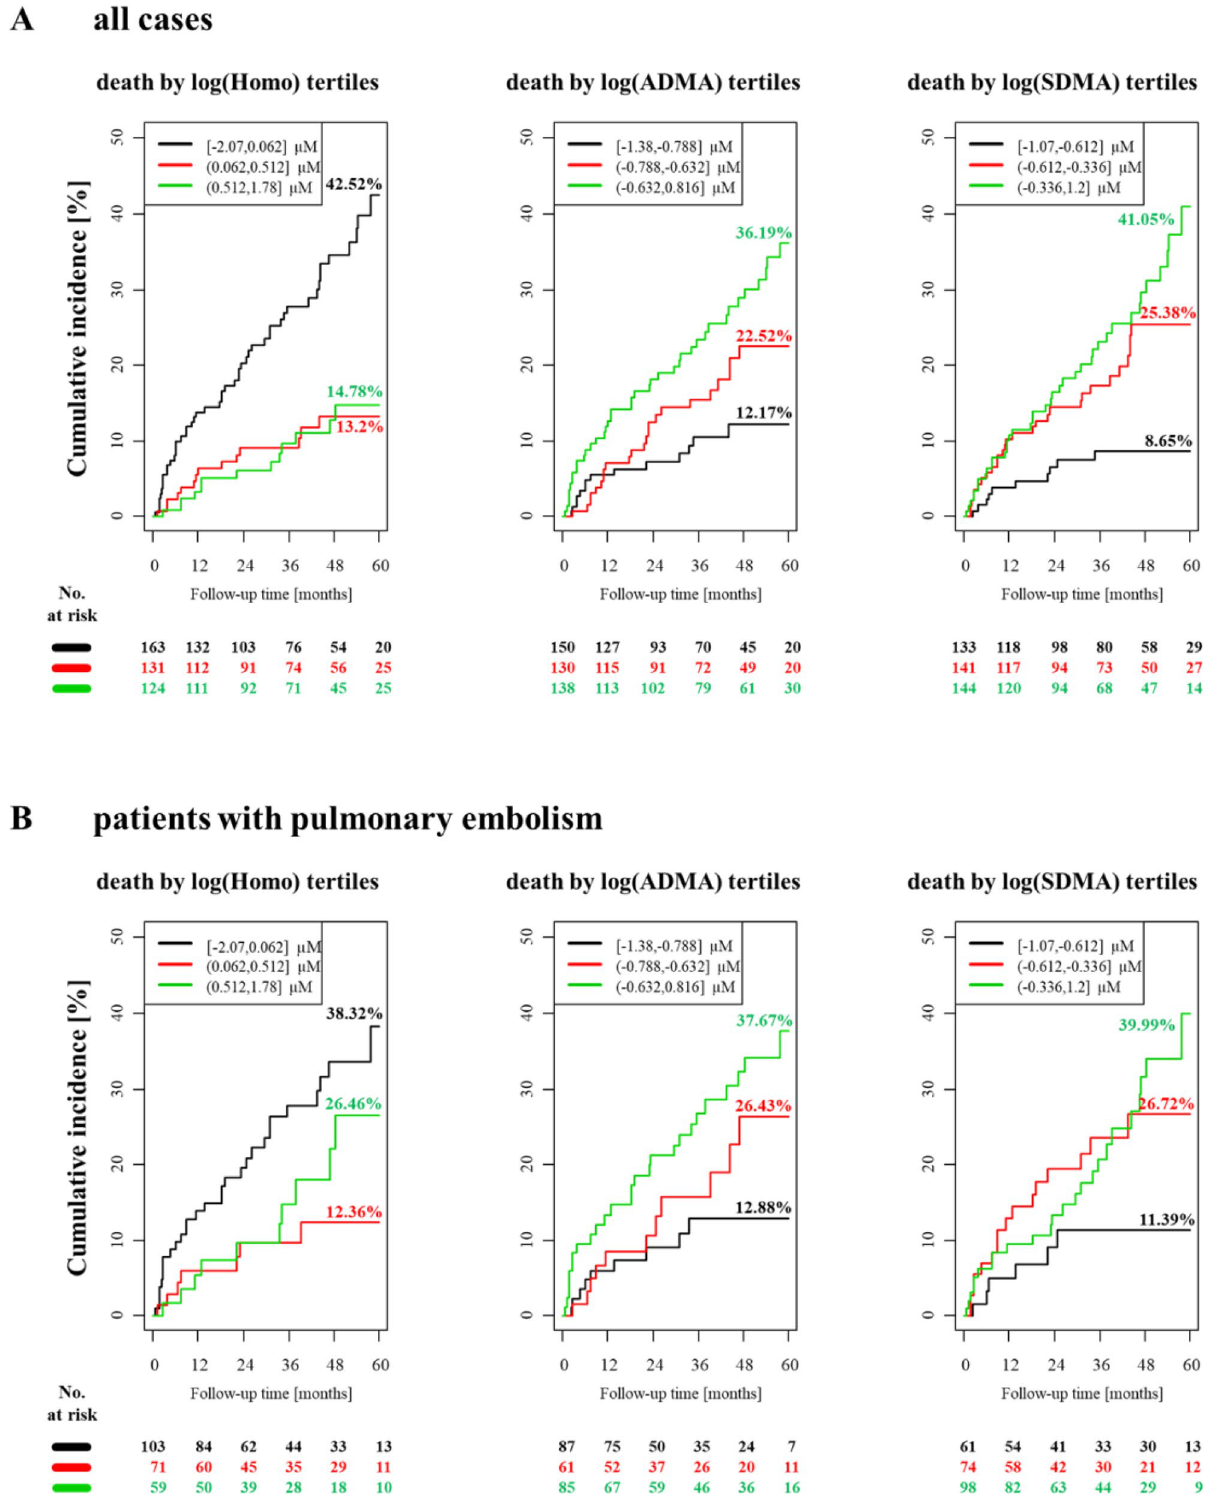
Figure 2. Homoarginine, ADMA, SDMA and the risk of death in the patients with confirmed VTE (cases). ( A ) Kaplan–Meier curves for all the VTE cases ( B ) Kaplan–Meier curves for all the PE cases ( C ) Kaplan–Meier curves for all the DVT cases ( D ) Cox regression analysis for all VTE cases. Adjustment for sex and age (‘sa’), sex, age and OAC (‘sao’) and for sex, age, OAC, BMI, arterial hypertension, diabetes mellitus, smoking, dyslipidemia, chronic heart failure, history of stroke, creatinine and cancer (‘risk’). Homo, homoarginine; ADMA, asymmetric dimethylarginine; SDMA, symmetric dimethylarginine; VTE, venous thromboembolism; PE, pulmonary embolism; DVT, deep vein thrombosis; OAC, oral anticoagulation; BMI, body mass index; HR, hazard ratio; CI, confidence